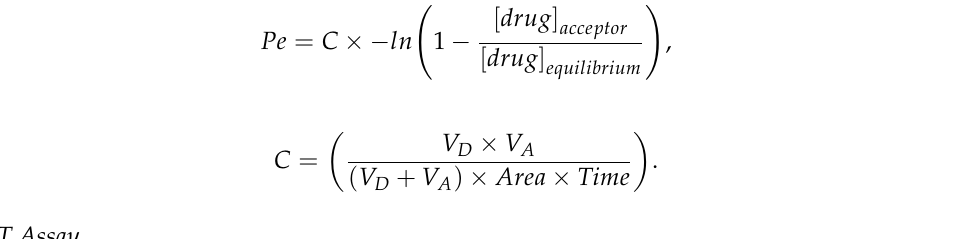
Supplementary Materials: The following are available online, Figure S1: Superposition of the suvorexant binding mode in OX2R determined by X-ray (colored in magenta, PDB ID: 4S0V) and by molecular docking in AutoDock Vina (colored in green), Figure S2: Interactions among the residues of agonistic tetrad (colored in green) in OX2R inhibited by suvorexant (i.e., PDB ID: 4S0V), Figure S3: Interactions of other residues in OX2R inhibited by suvorexant (PDB ID: 4S0V), which are considered to stabilize inactivated conformation of OX2R, Figure S4: Typical dose-response effect by orexin A (0–500 nM) stimulation, Figure S5: Typical dose-response effect of suvorexant after orexin A (100 Table S2: Evaluation of identity and uncalibrated purity of L1 – L11 with